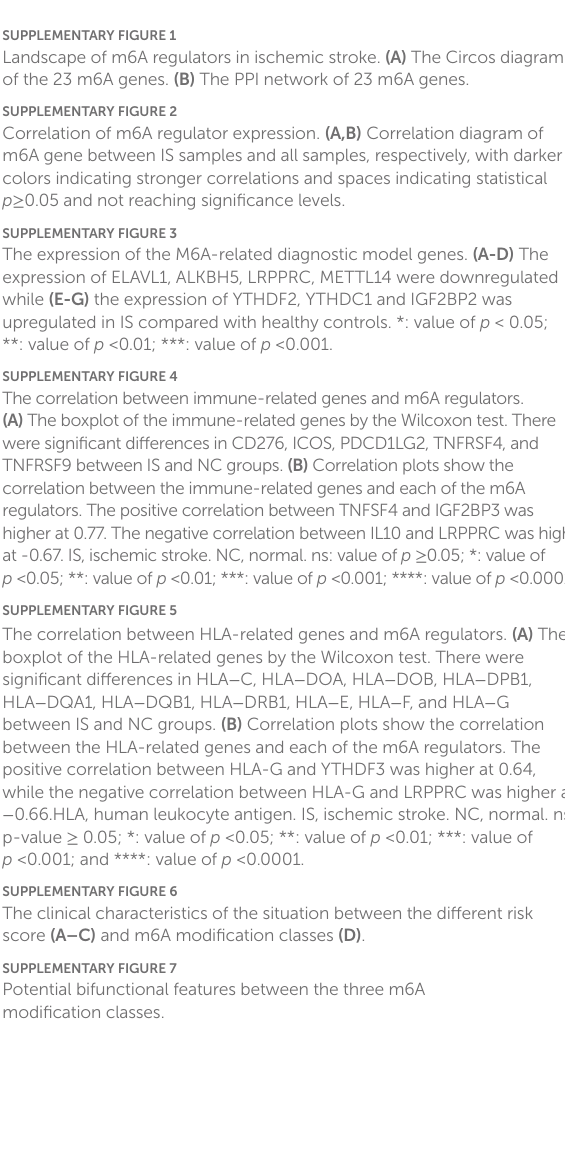
SUPPLEMENTARY FIGURE 6 The clinical characteristics of the situation between the different risk score (A–C) and m6A modification classes (D) . SUPPLEMENTARY FIGURE 7 Potential bifunctional features between the three m6A modification